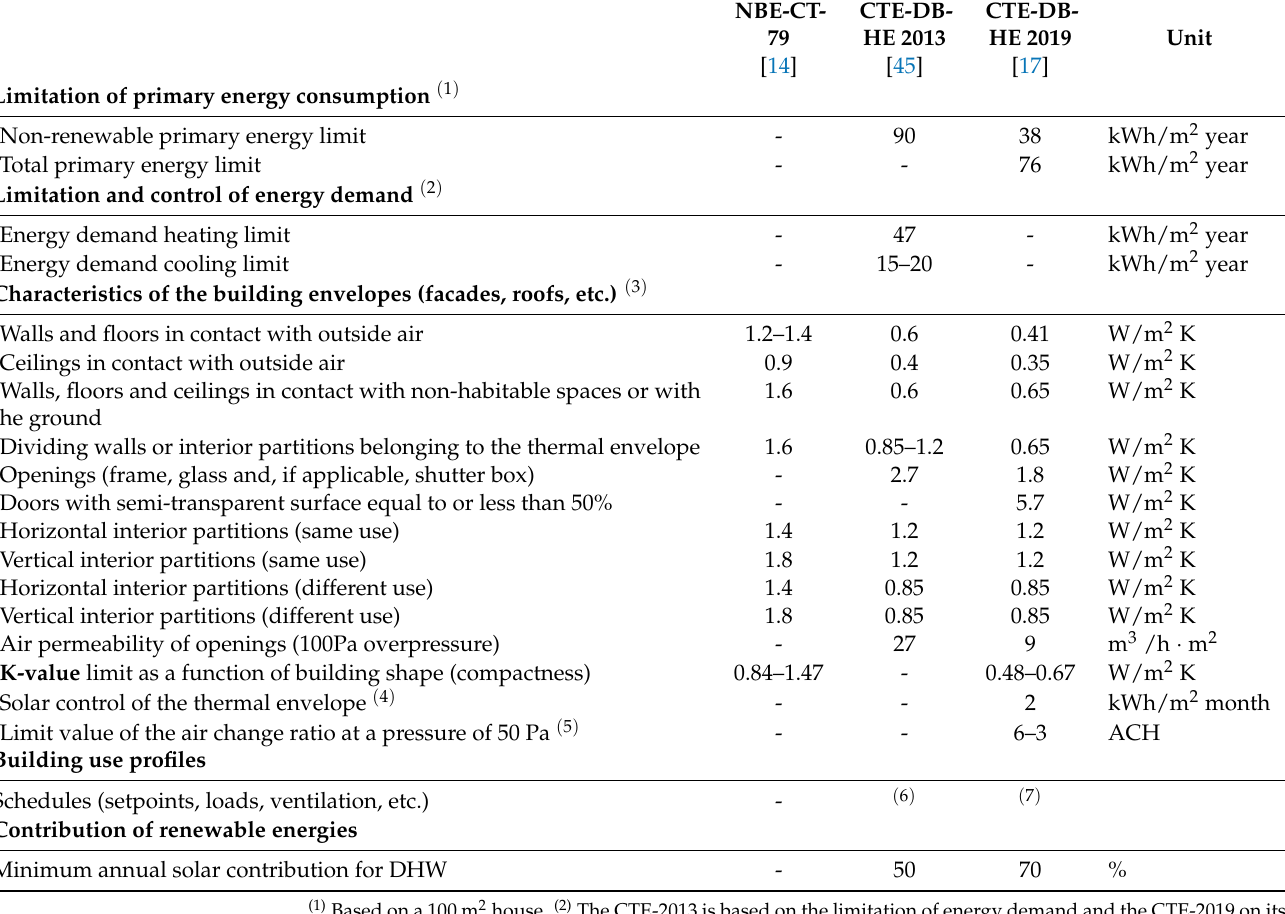
Table 1. Differences between the Spanish technical energy